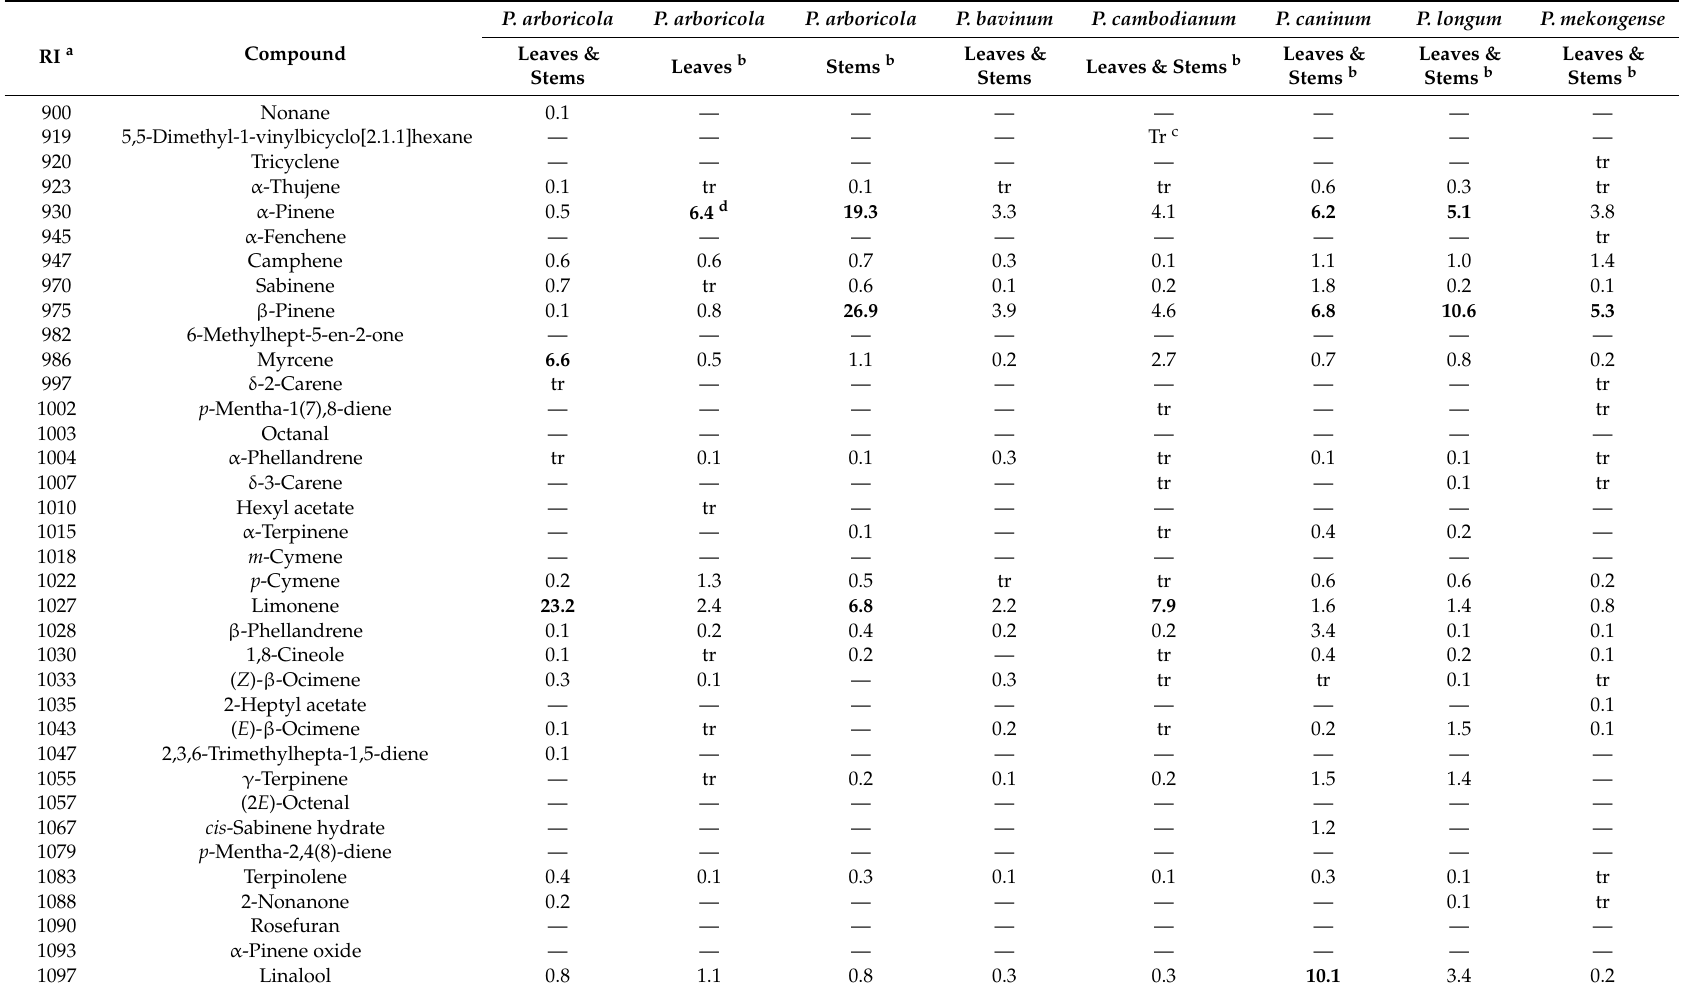
Table 2. Essential oil compositions (%) of Piper species from central